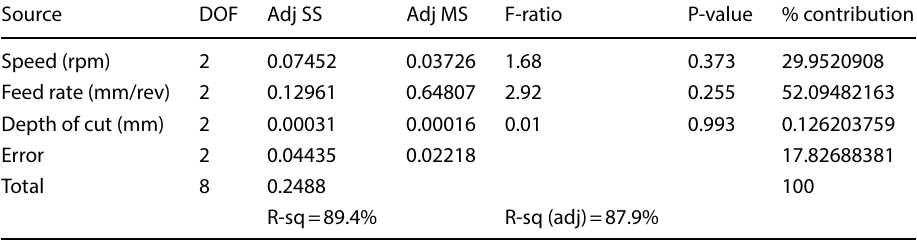
Table 4 Analysis of variance (ANOVA) result for surface